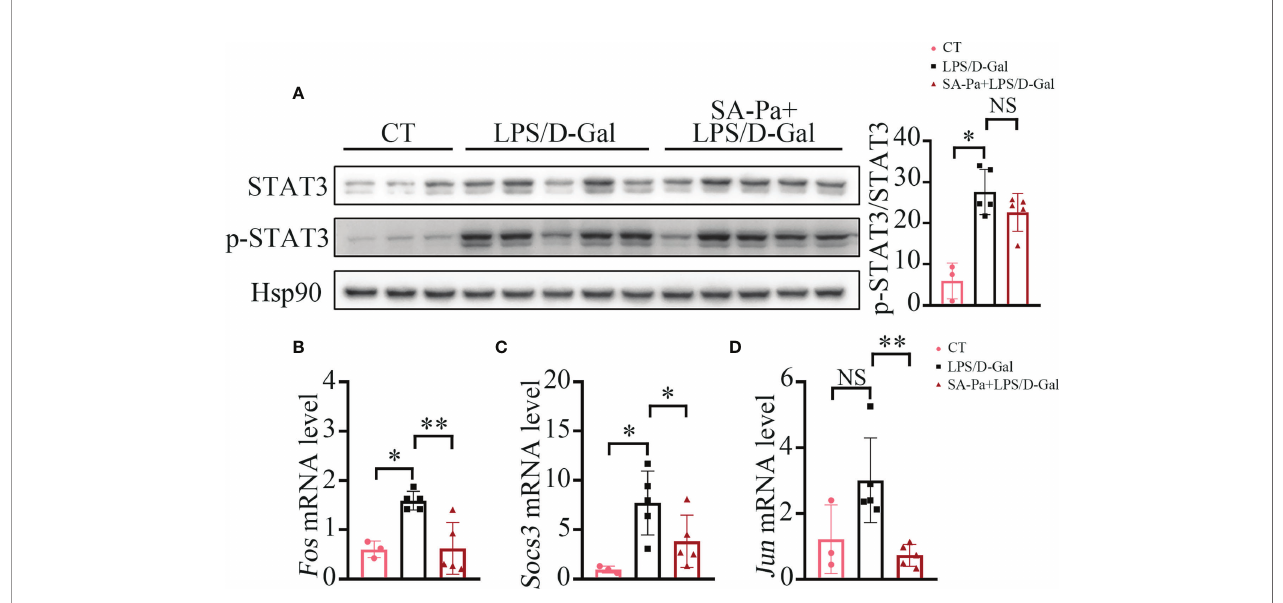
FIGURE 5 | SA-Pa inhibited the transcription levels of STAT3-targeted genes after the LPS/D-Gal injury. (A) Western blots and quantitative results for p-STAT3/ STAT3 in the liver of indicated groups. (B-D) qPCR results of the indicated genes in the liver of indicated groups (CT group, n = 3; LPS/D-Gal group, n = 5; SA-Pa group, n = 5; NS p > 0.05; *p > 0.05; **p < 0.01).